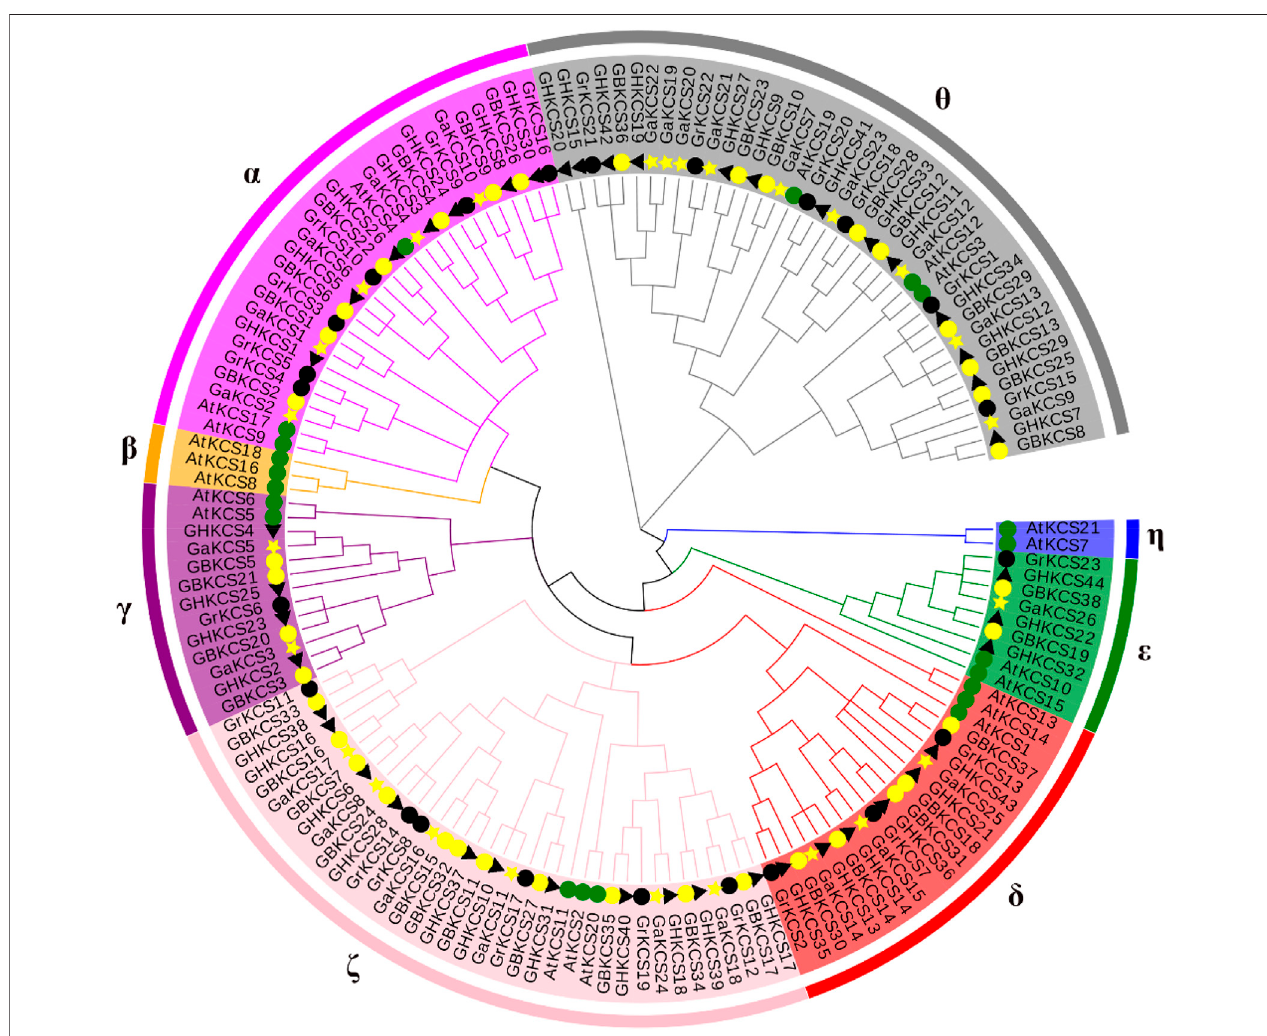
FIGURE 1 | Phylogenetic analysis of KCS protein from Gossypium and Arabidopsis . (The rootless phylogenetic tree was constructed by MEGA7.0).